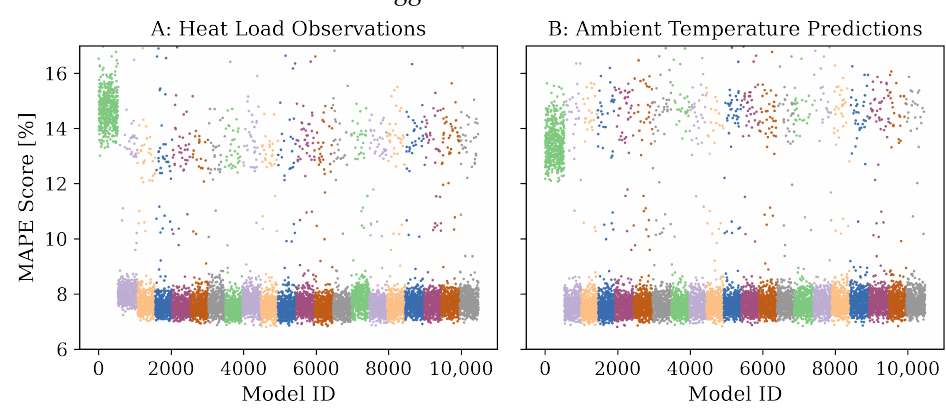
Figure 6. Influence of the number of lagged features on the performance of the models with a forecast horizon of 22 h. The number of lagged features varies between zero (far left in green) and twenty (far right in grey) for ( A ) previous heat load observations and ( B ) ambient temperature